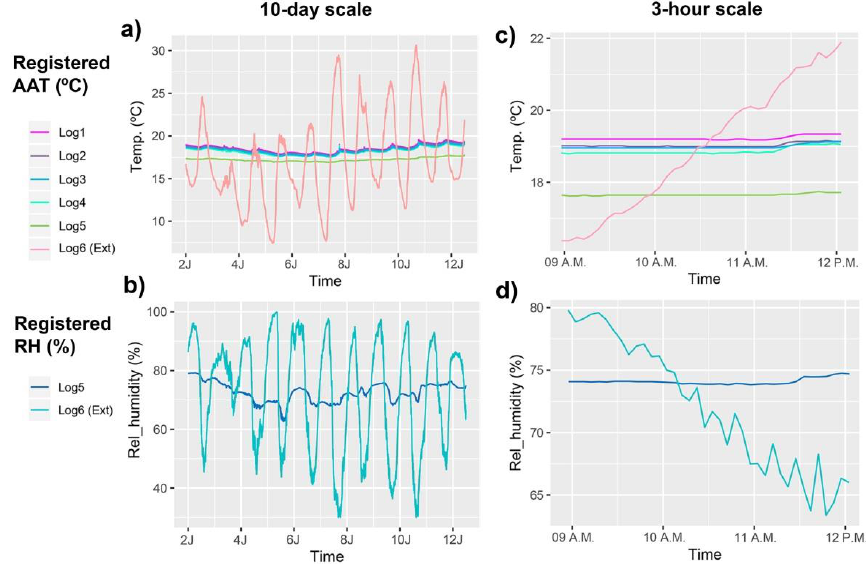
Figure 7. Data recorded by indoor and outdoor data loggers: ( a ) ambient air temperature (AAT) and ( b ) relative humidity (RH) during the 10 days prior to the test (from the 2nd – 12 June 2017) and ( c ) AAT and ( d ) RH during the three hours of the thermal imagery campaign (from 09:00 – 12:00 on 12 June,